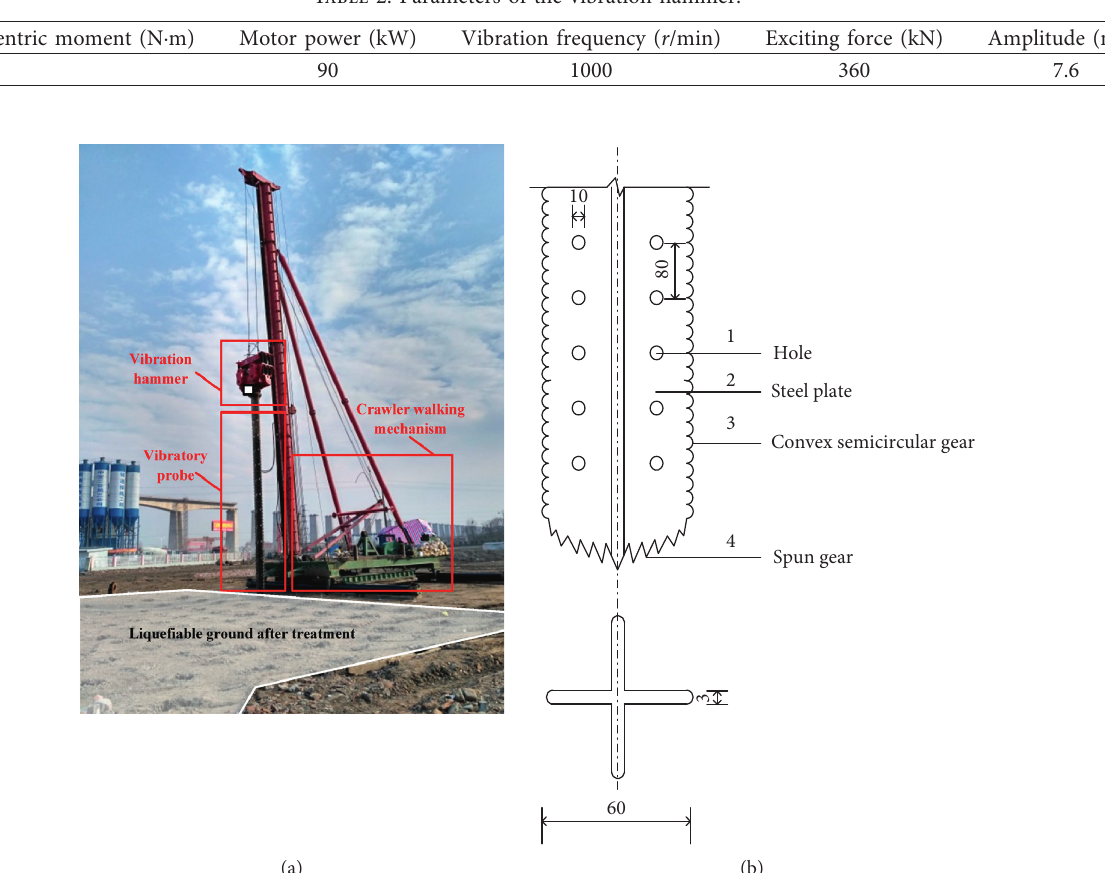
Table 2: Parameters of the vibration hammer.